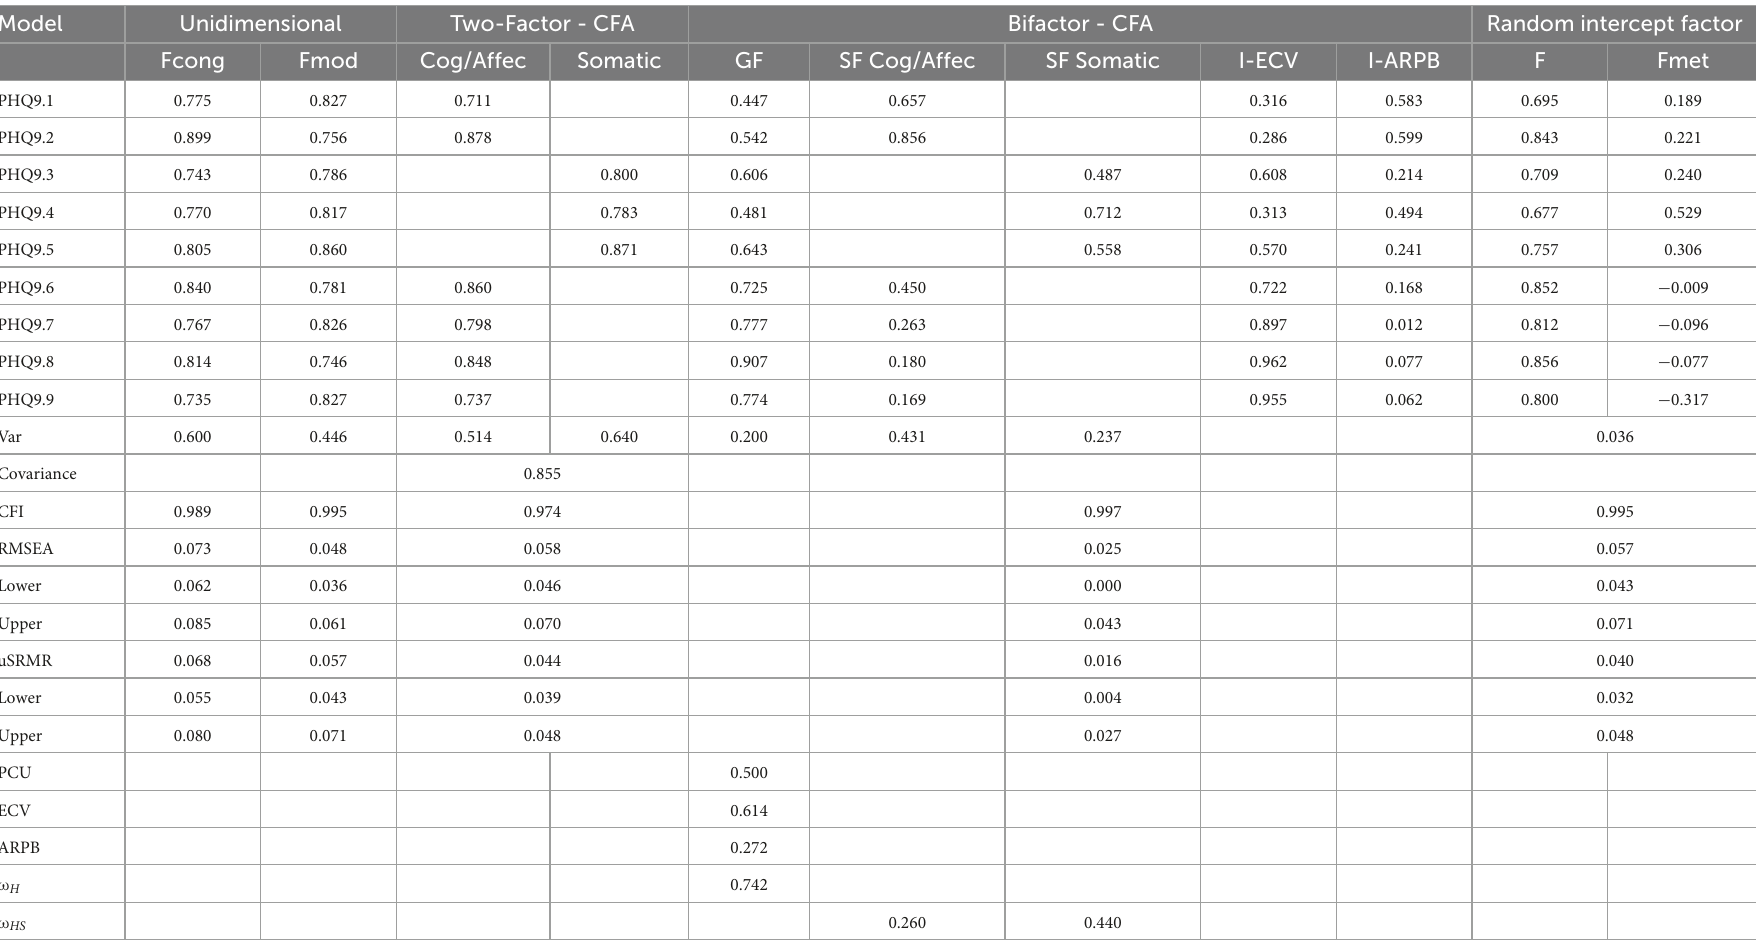
TABLE 4 Fit indices, factor loadings, and ancillary bifactor statistics of the PHQ-9 models.